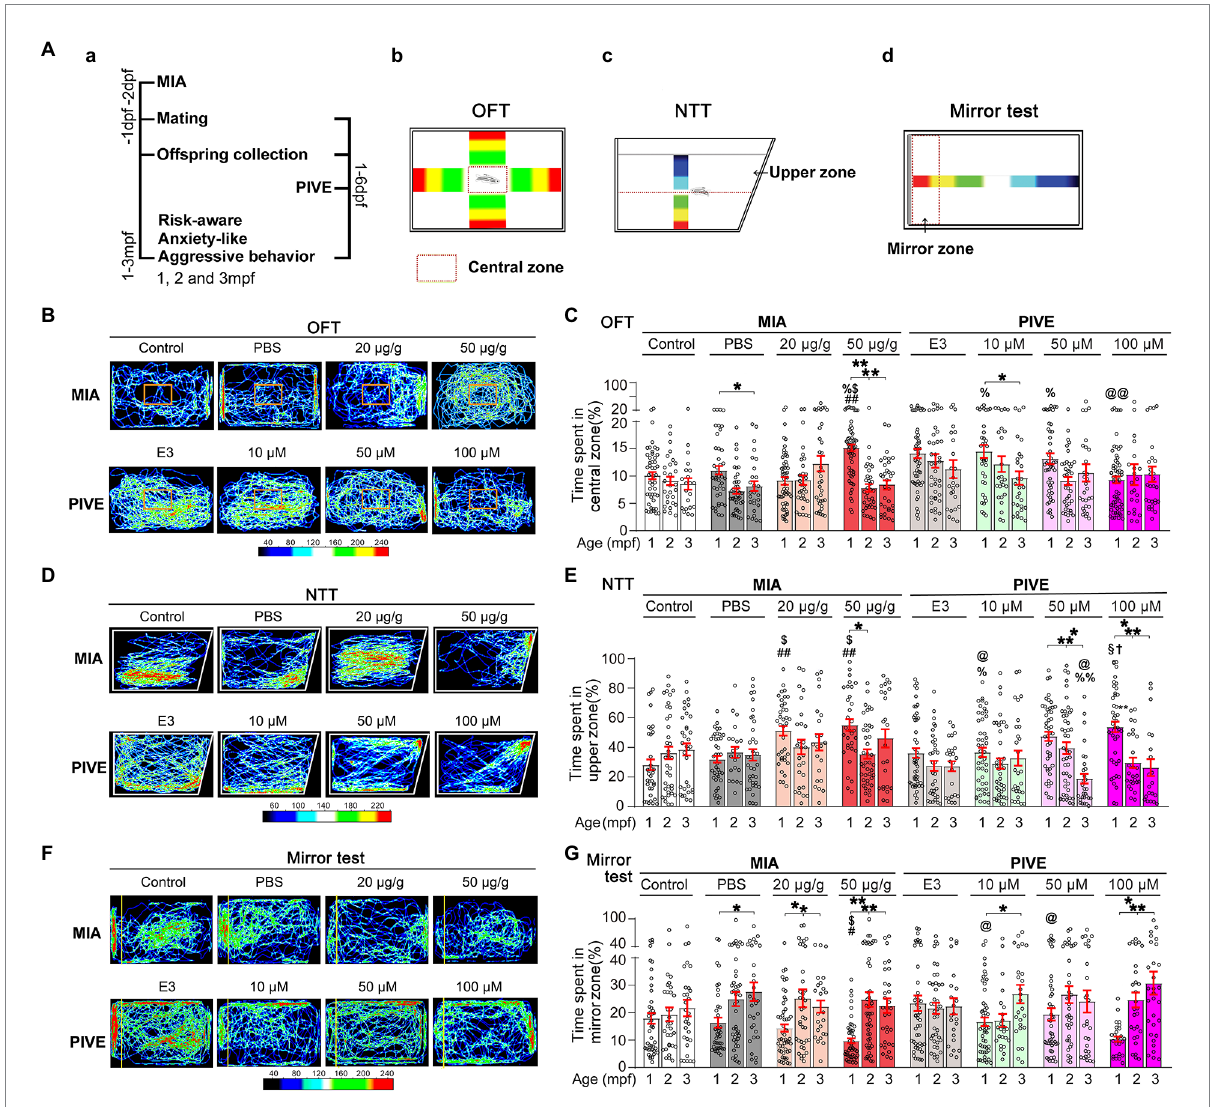
FIGURE 5 MIA offspring exhibited a decreased risk-aware, anxiety-like and aggressive behavior. (Aa) OFT (Ab) , NNT (Ac) , and mirror (Ad) tests were used to evaluate the risk-awareness, anxiety-like and aggressive behavior at 1, 2, and 3 mpf of MIA or PIVE fish. (B) Video tracking of movements of MIA or PIVE fish during OFT. (C) Only MIA-50 μ g/g exhibited a decreased risk-awareness at 1 mpf (MIA-50 μ g/g: Z = 4.41 and 3.48, p < 0.01 and 0.05 vs. MIA- Control and MIA-PBS respectively), as they spent more time in the central zone of the tank. (D) Video tracking of movements of MIA or PIVE fish during NNT. (E) MIA-20 and 50 μ g/g exhibited a decreased anxiety-like behavior at 1 mpf as they spent more time in upper zone of the tank (MIA- 20 μ g/g: Z = 4.17 and 3.46, p < 0.01 and < 0.05 vs. MIA-Control and MIA-PBS, respectively. MIA-50 μ g/g: Z = 4.45 and 3.77, p < 0.01 and < 0.05 vs. MIA- Control and MIA-PBS, respectively); as well as observed at 1 mpf in PIVE-100 μ M group ( Z = 3.21, p < 0.05 vs. PIVE-E3 group). (F) Video tracking